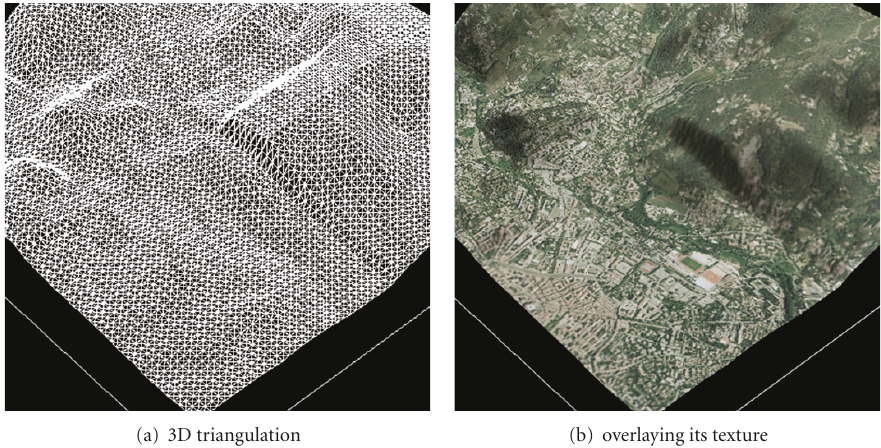
Figure 21: 3D views with the tessellation after smoothing with Method I: d m = 2, d h = 1 ( l h = 0, l m = 2, l l = 3).